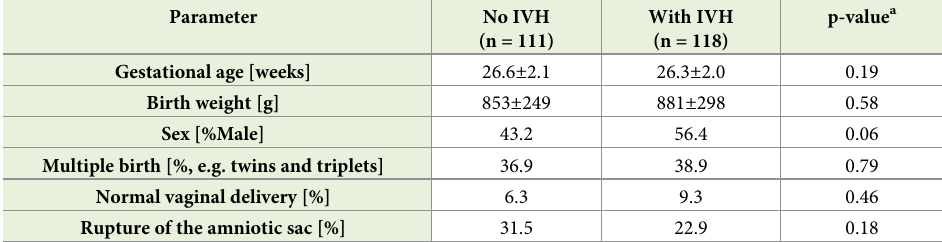
Table 1. Obstetric characteristics of the cohort.